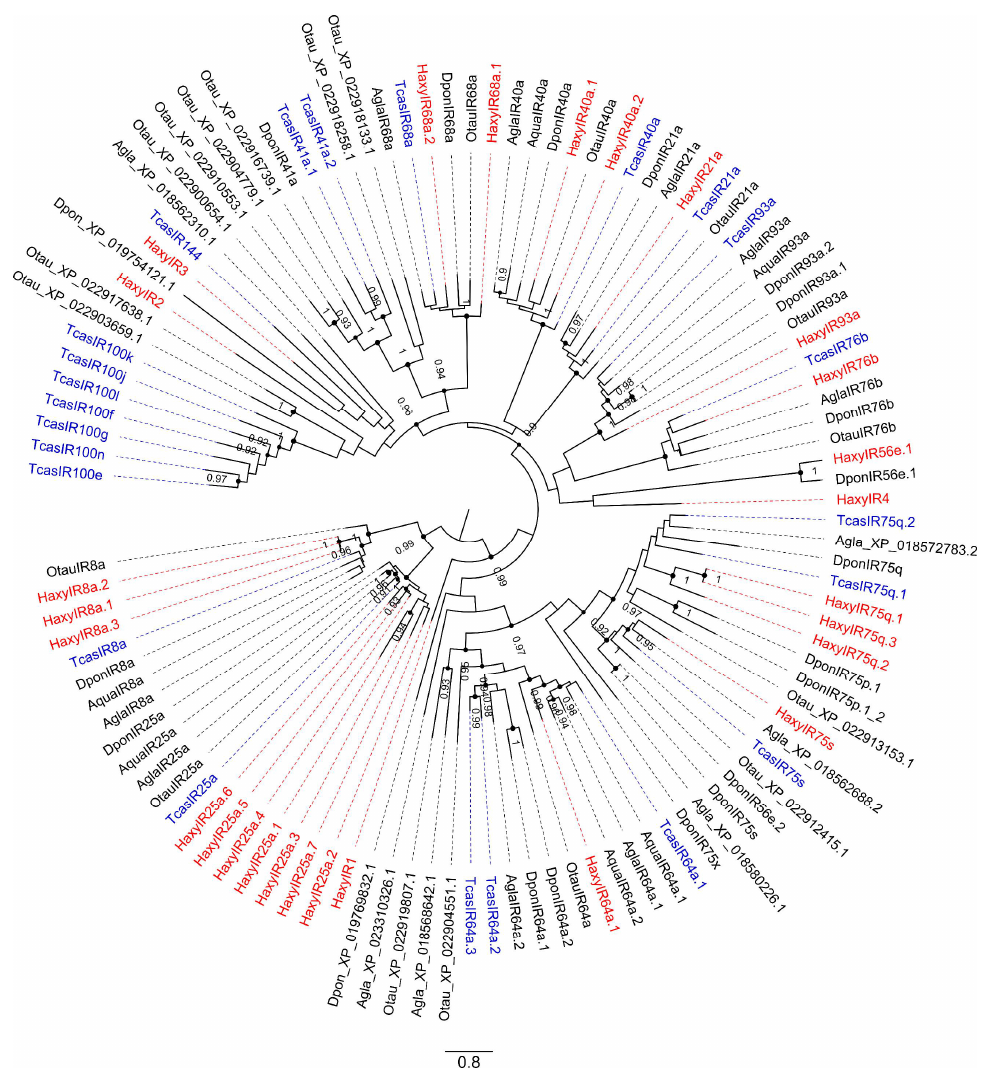
Figure 3. Phylogenetic tree of ionotropic receptors (IRs). Red: Harmonia axyridis (Haxy); blue: Tribolium castaneum (Tcas); black: Ambrostoma quadriimpressum (Aqua), Anoplophora glabripennis (Agla), Dendroctonus ponderosae (Dpon), and Onthophagus taurus (Otau). Numbers and symbols at nodes represent support values higher than 0.9, where 1 represents maximal support.